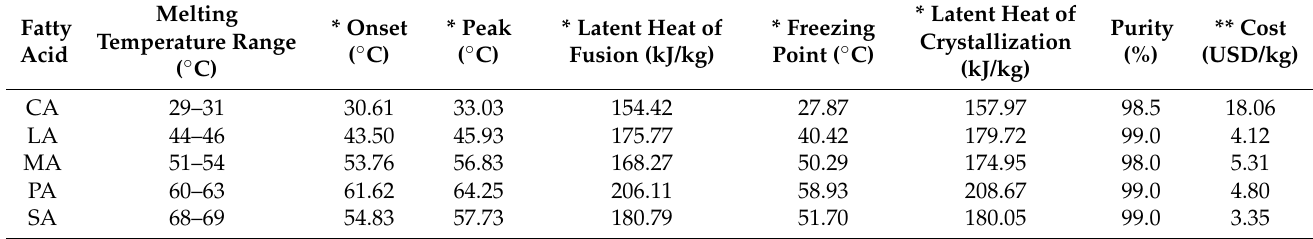
Table 1. Thermophysical properties of crude fatty